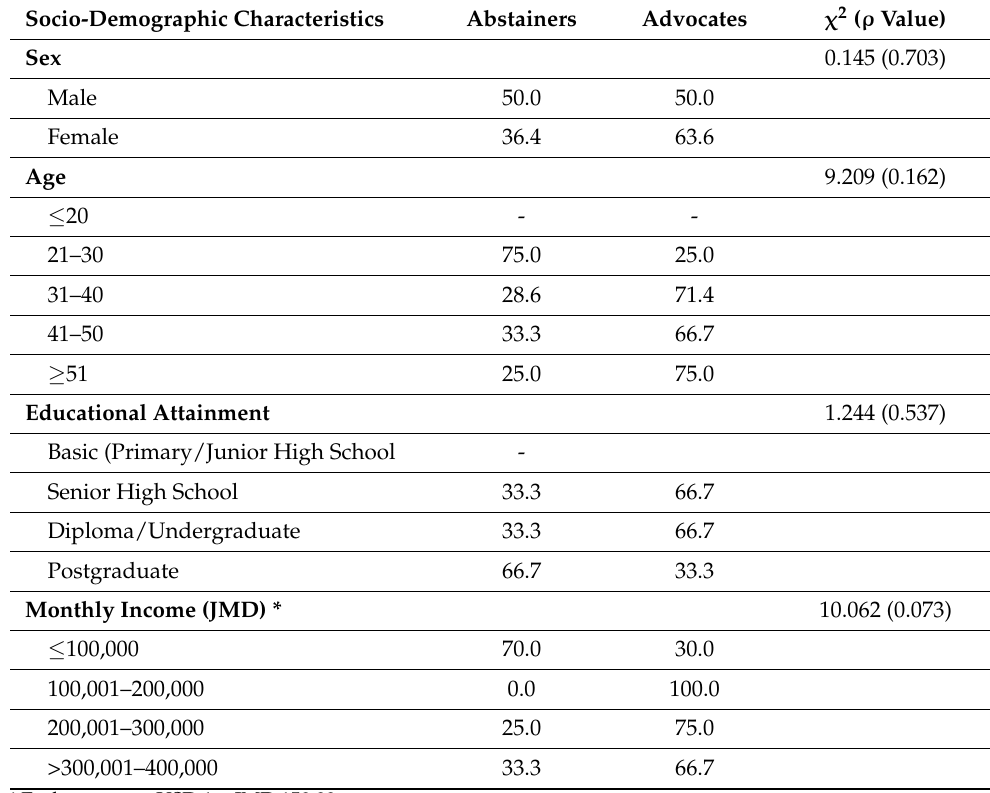
Table 6. Teacher cluster profiles by socio-demographic